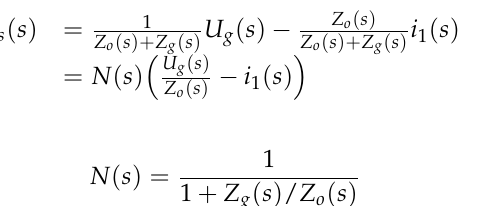
Figure 6. Equivalent circuit of grid-connected system.